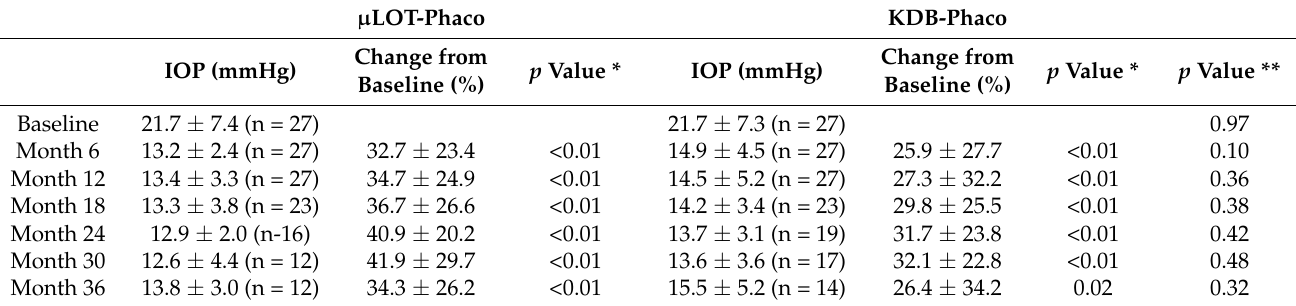
Table 2. Differences in preoperative and postoperative IOP.